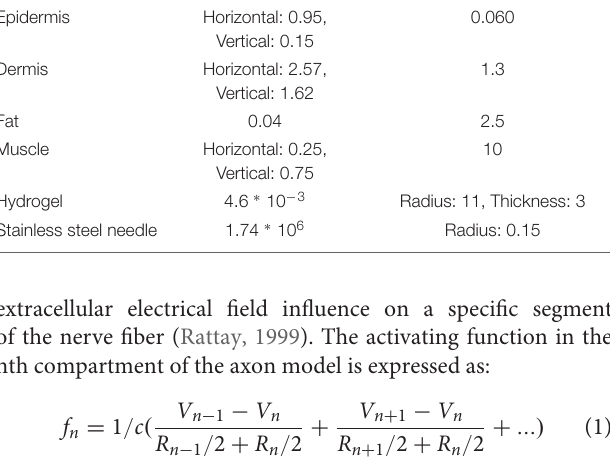
TABLE 2 | The electrical conductivity and thickness of each layer in the finite element model. Layer Electrical conductivity